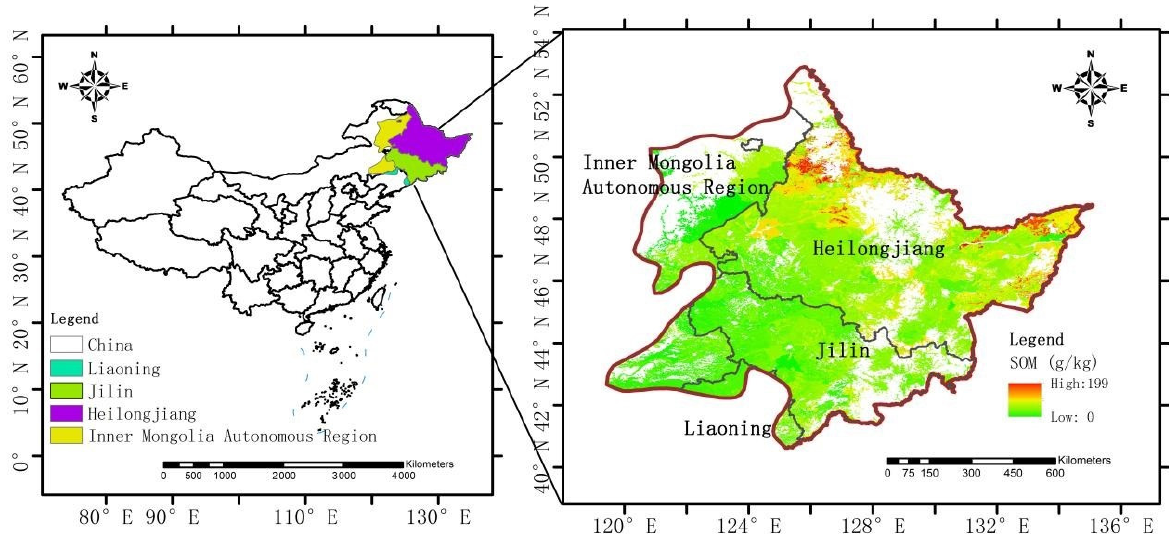
Figure 1. The location of the study area and SOM concentration.